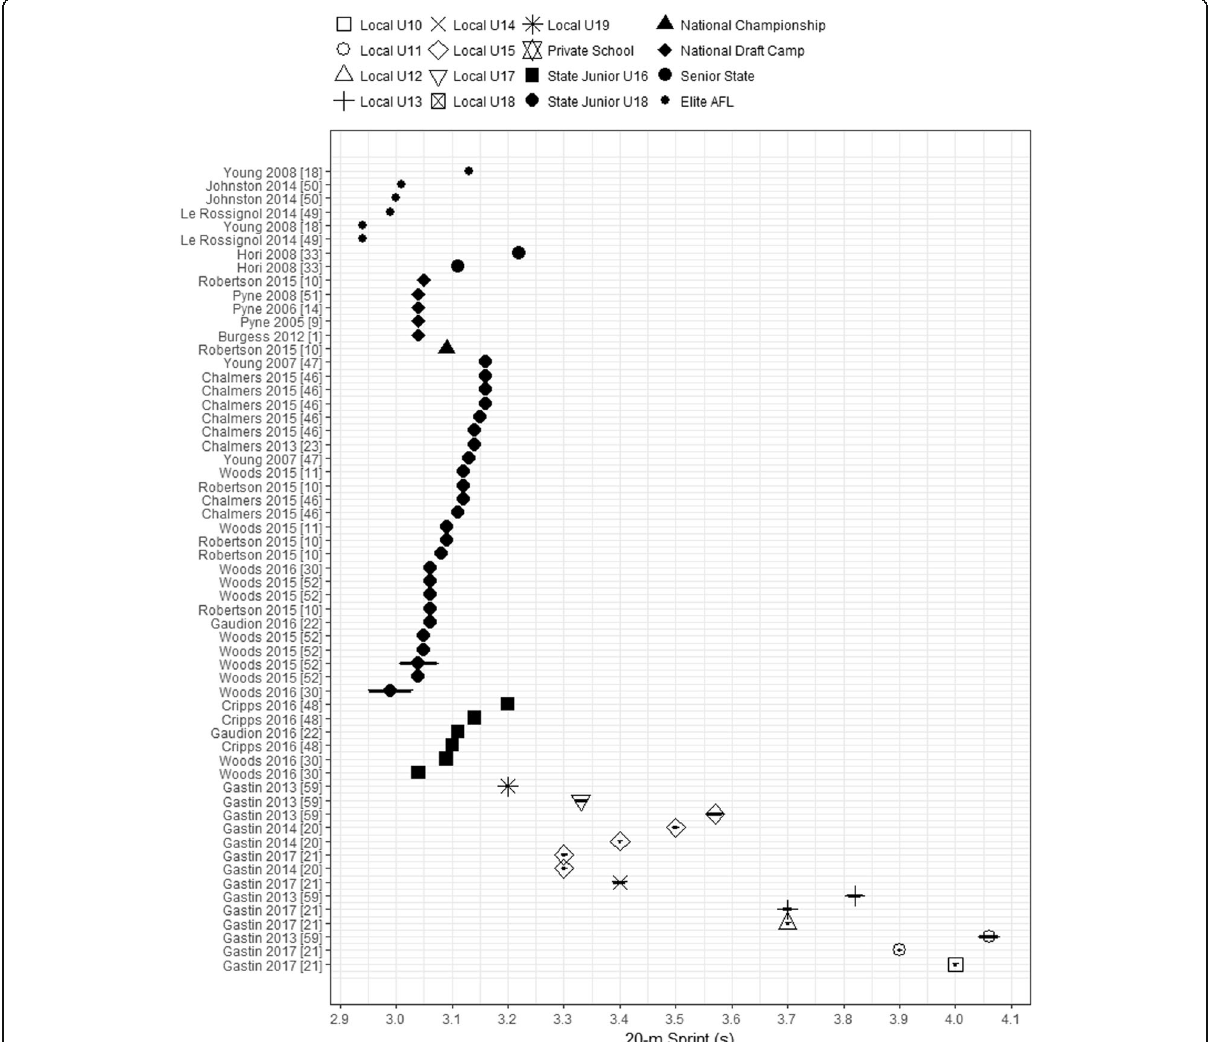
Fig. 3 Mean and CIs of reported 20-m sprint times across the AFL participation pathway levels. Values are ordered by position in AFL participation pathway, then by sample size reported for each group. All players ’ levels are shown in the legend for consistency though not all levels may have data on the charted performance measure. AFL Australian Football League, U